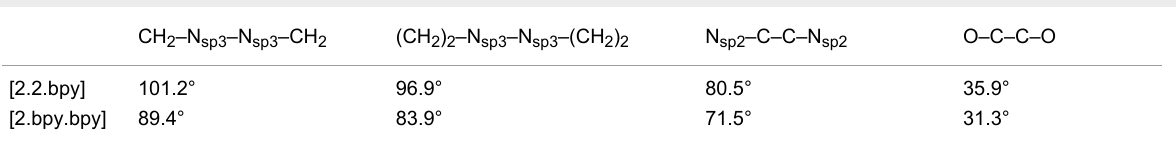
Table 9: (Maximum) range of the calculated torsion angles.